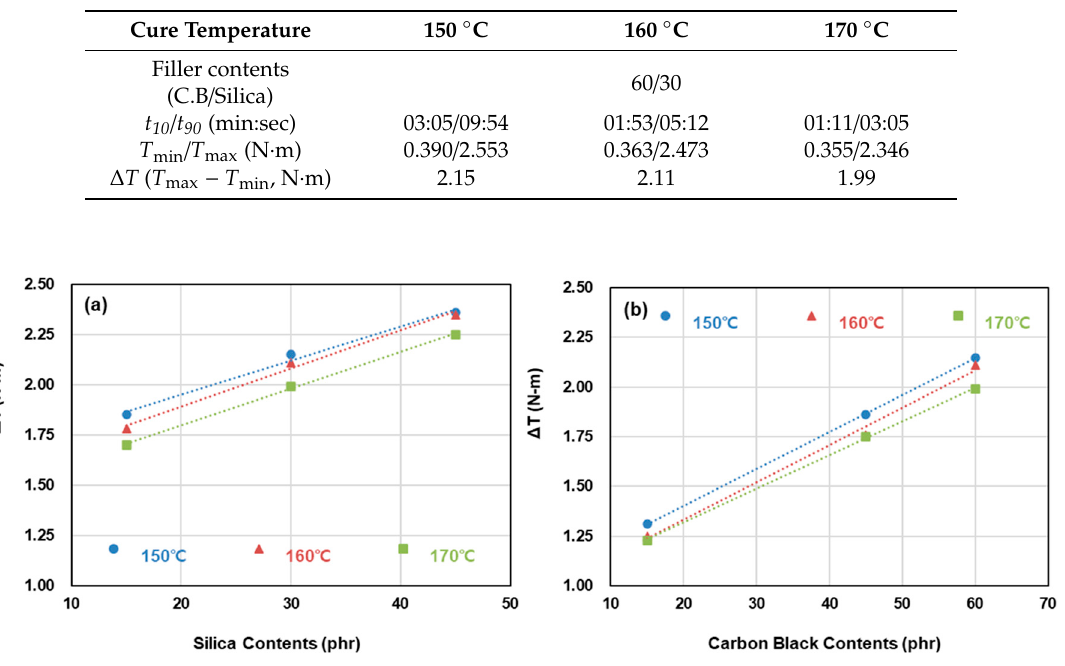
Figure 4. Cure characteristics of compounds with a carbon black and silica binary filler system: ( a ) carbon black contents: 60 phr, silica contents: 15, 30, and 45 phr, ( b ) silica contents: 30 phr, carbon black contents: 15, 45, and 60 phr.